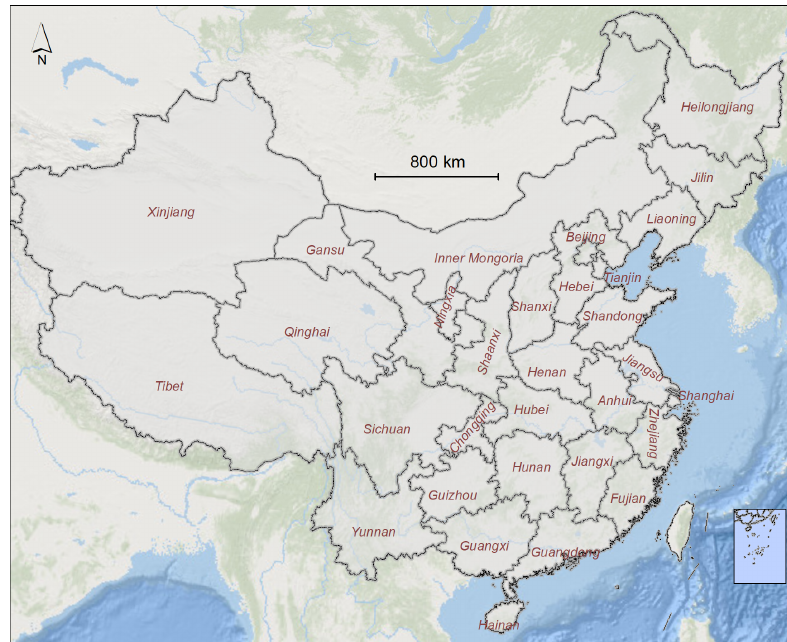
Figure A5. Chinese province distribution map. The China Provincial Map layer comes from the Data Center for Resources and Environmental Sciences, Chinese Academy of Sciences, which is accessible from the Resource and Environment Data Cloud Platform (http://www.resdc.cn/, last access: 19 May